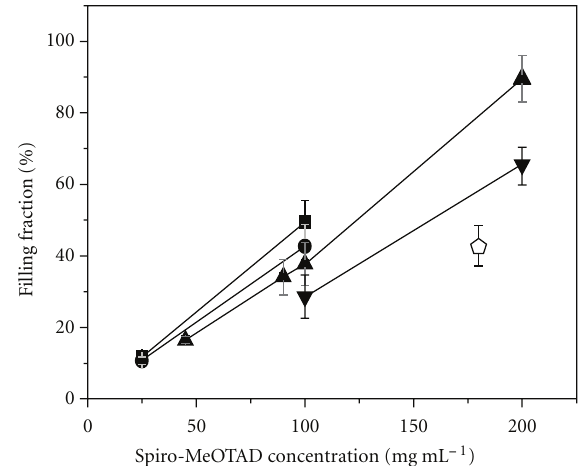
Figure 3: Filling fraction versus spiro-MeOTAD concentration, cal- culated according (1a) and (1b), for samples with TiO 2 thicknesses of: 1.4 μ m ( (cid:2) ); 1.7 μ m ( • ); 2 μ m ( (cid:3) ); 3 μ m ( (cid:4) ); 5 μ m ( (cid:2)